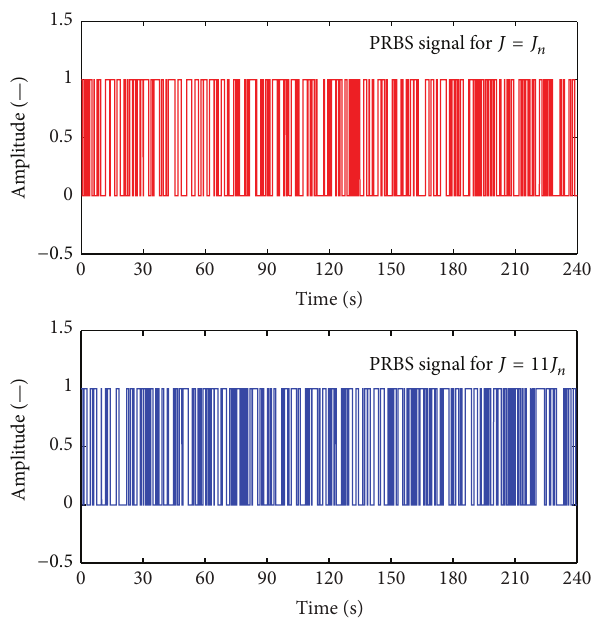
Figure 11: Excitation (pseudorandom binary sequence) signals used for training and test data acquisition for neural network training and validation (different signals were used for nominal and 11-multiple moments of